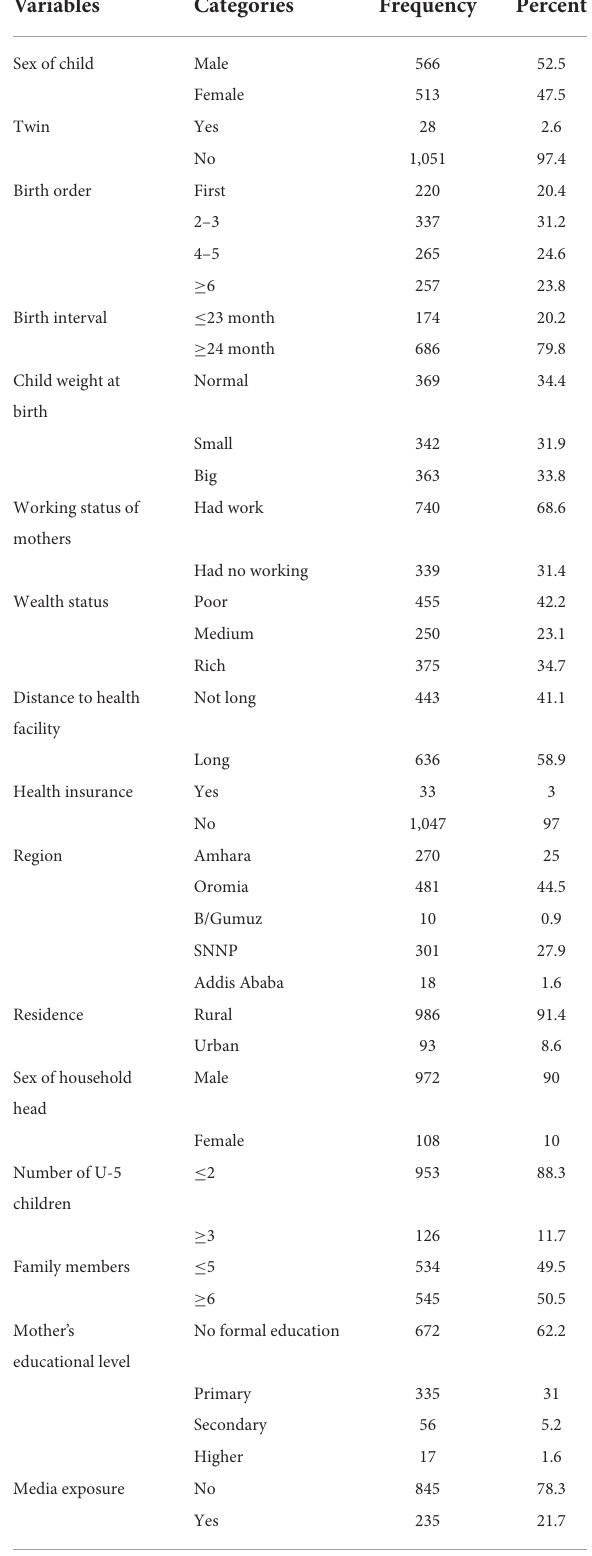
TABLE 1 Characteristic’s frequency and percentage distribution of study participants in Ethiopia in